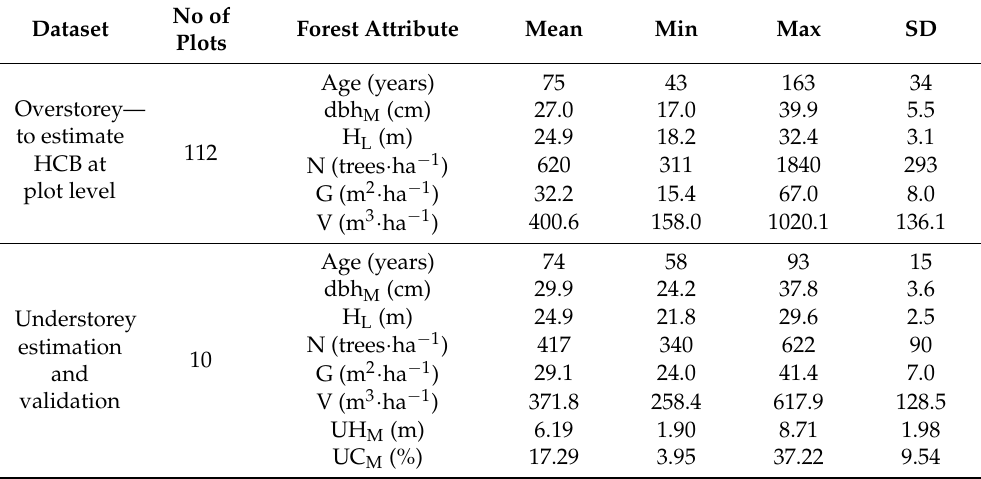
Table 1. Summary of the main plot-level forest attributes for 112 sample plots used to estimate the height to canopy base at plot level (overstorey) and 10 sample plots used for understorey estimation and